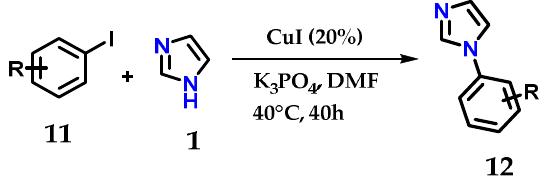
Figure 10. Catalytic N -arylation of imidazole 1 with aryl iodides and CuI. Exploring the bifunctionalization of 1,2-disubstituted acetylenes 13 by ruthenium carbonyl to form cis -enediol diacetates 14 , followed by reaction with ammonium carbonate as a source of nitrogen and methanol for the C -2 carbon, permitted us to obtain monosub- stituted imidazoles 15, as shown below (Figure 11). In reactions where (R) were aromatic rings, both substituents, withdrawers (EWG) and donors (EDG) were tolerated under the applied conditions [22].